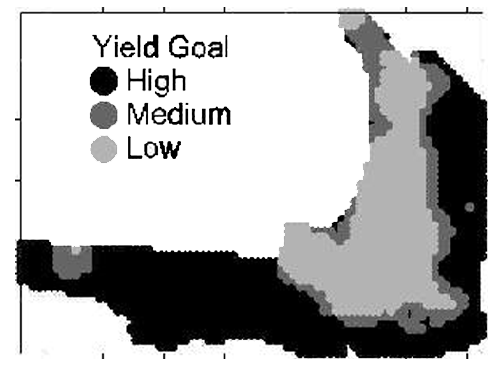
FIGURE 15. Yield goal map based on 3-year historical yields and soil EC data.